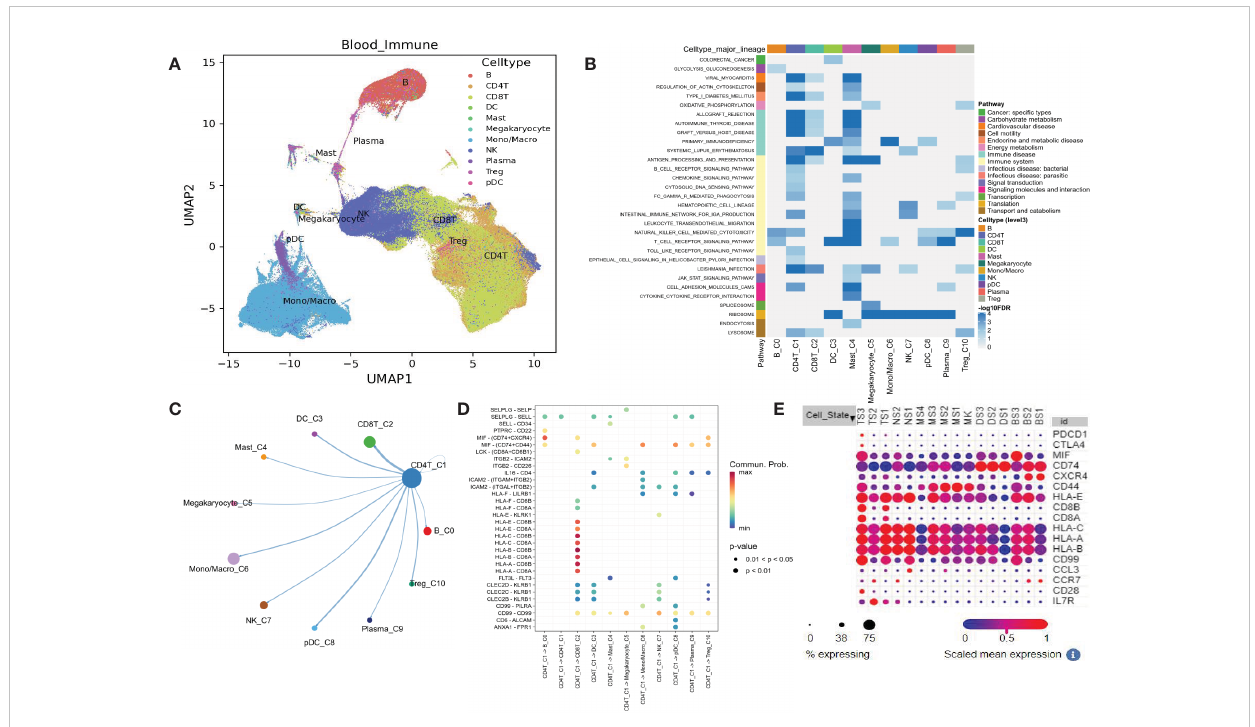
FIGURE 2 Single-cell transcriptome analysis shows the KEGG pathway differentially expressed in blood from healthy controls and potential mechanisms. (A) UMAP plot for the 11 immune cell clusters. (B) Heatmap shows some down-regulated pathways. (C) Circular plot for cell communications between CD4 + T cell and other 10 immune cells. (D) All the signi fi cant ligand-receptor pairs that contribute to the signaling sending from CD4 + T cell and other 10 immune cells. (E) The expression dot plot shows two sub-clusters TS3 and TS2 associated with T cell exhaustion. TS, T cell subclusters; NS, NK cell subclusters; MS, monocyte/macrophage subclusters; MK, megakaryocyte subclusters; DS, dendritic cell (DC) subclusters; BS, B cell subclusters.